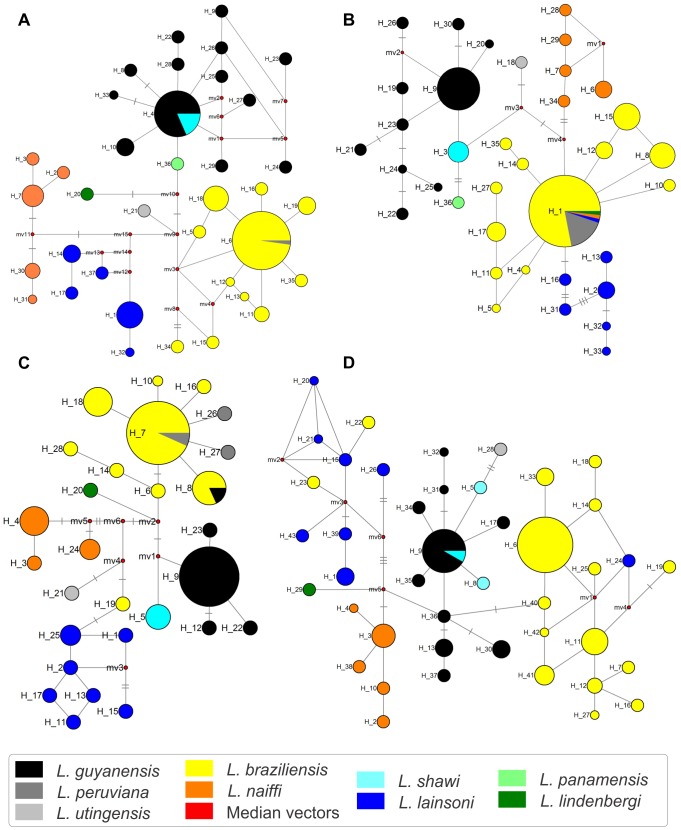
Maximum parsimony-based haplotype networks.A) G6PD; B) 6PGD; C) MPI; D) ICD. The 96 strains selected for the study (Table S1) plus sequences of Leishmania (Viannia) strains retrieved from GenBank (Table S2) were included. Haplotype frequency is represented by the size of each node and the numbers of polymorphisms are indicated in the branches by dashes: one = 02 to 05 polymorphism; two = 06 to 10; three = more than 10 polymorphisms. Each species, considering the MLEE characterization, were assigned by different colors as coded by the legend.